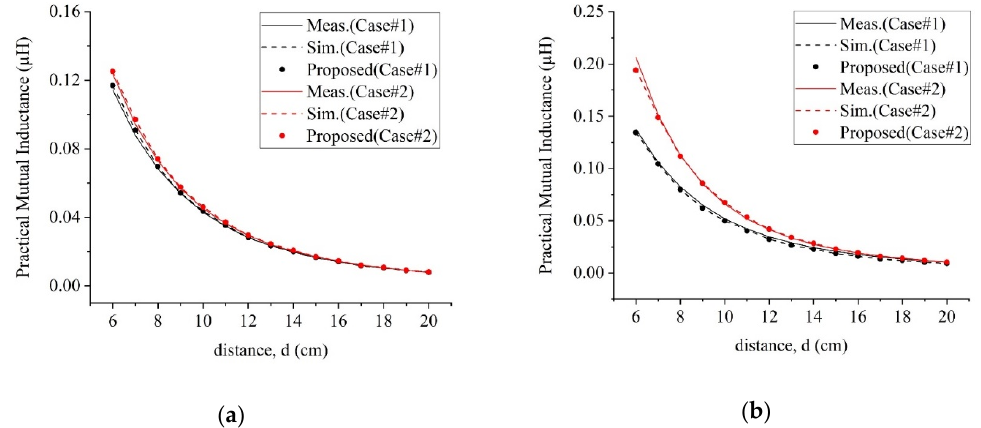
Figure 9. Practical mutual inductance between Coils 1 and 3 with distance: ( a ) 6.78 MHz; and ( b ) 13.56 MHz. Table 3. Mean and normalized root-mean-square error (NRMSE) of di ff erence between the results of measurement and the proposed method for Figures 8 and 9.